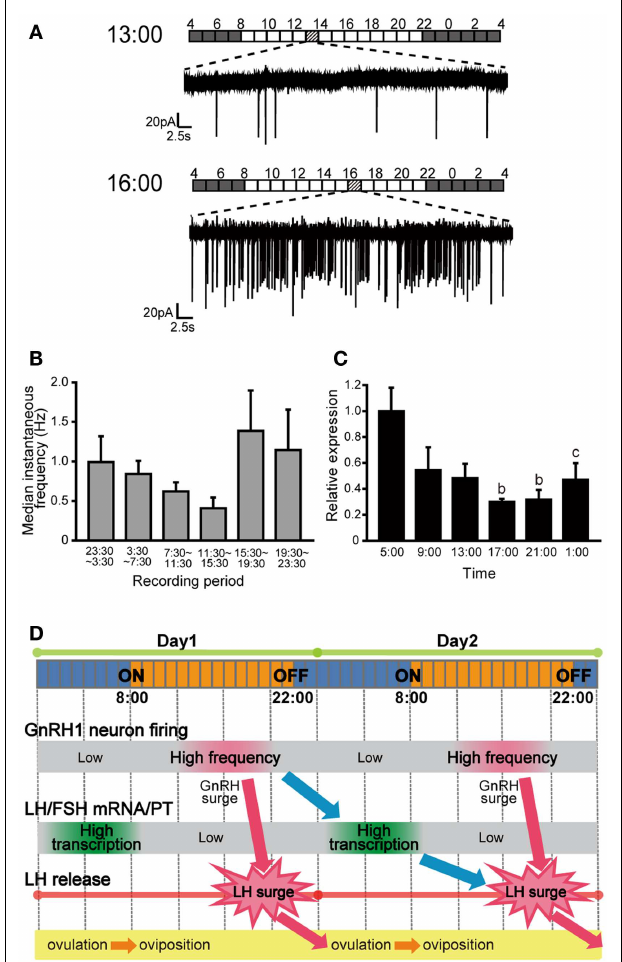
FIGURE 3 | Spontaneous electrical activity of GnRH1 neurons and the pituitary gonadotropin mRNA expression levels, and their time-of-day changes . (A) Spontaneous firing activities of GnRH1-GFP neurons for 1min in the time period preceding the putative LH surge (at 1300h) and just before or during the putative LH surge (at 1600h). Bars above the traces indicate the lighting conditions of the aquarium room. (B)